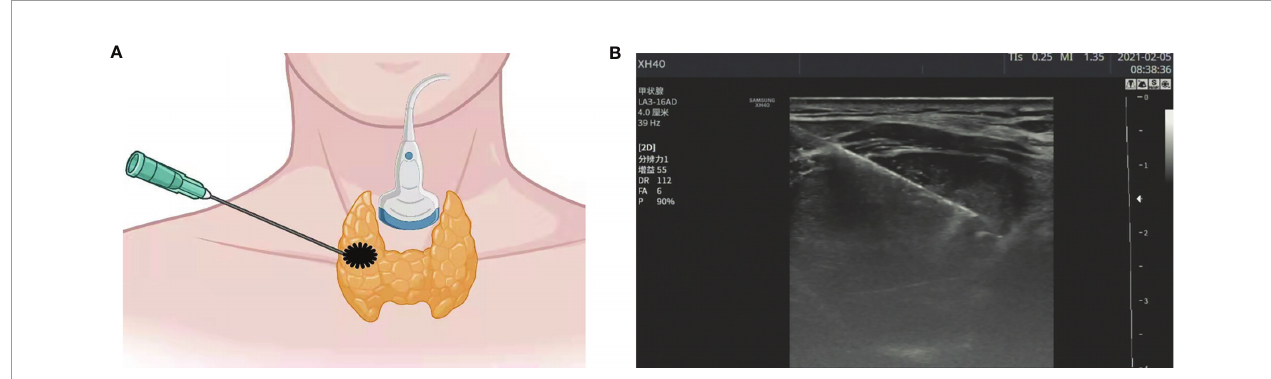
FIGURE 1 | (A) Schematic diagram of ultrasound (US)-guided fi ne needle aspiration biopsy (thyroid nodule). (B) US image of fi ne needle aspiration (thyroid